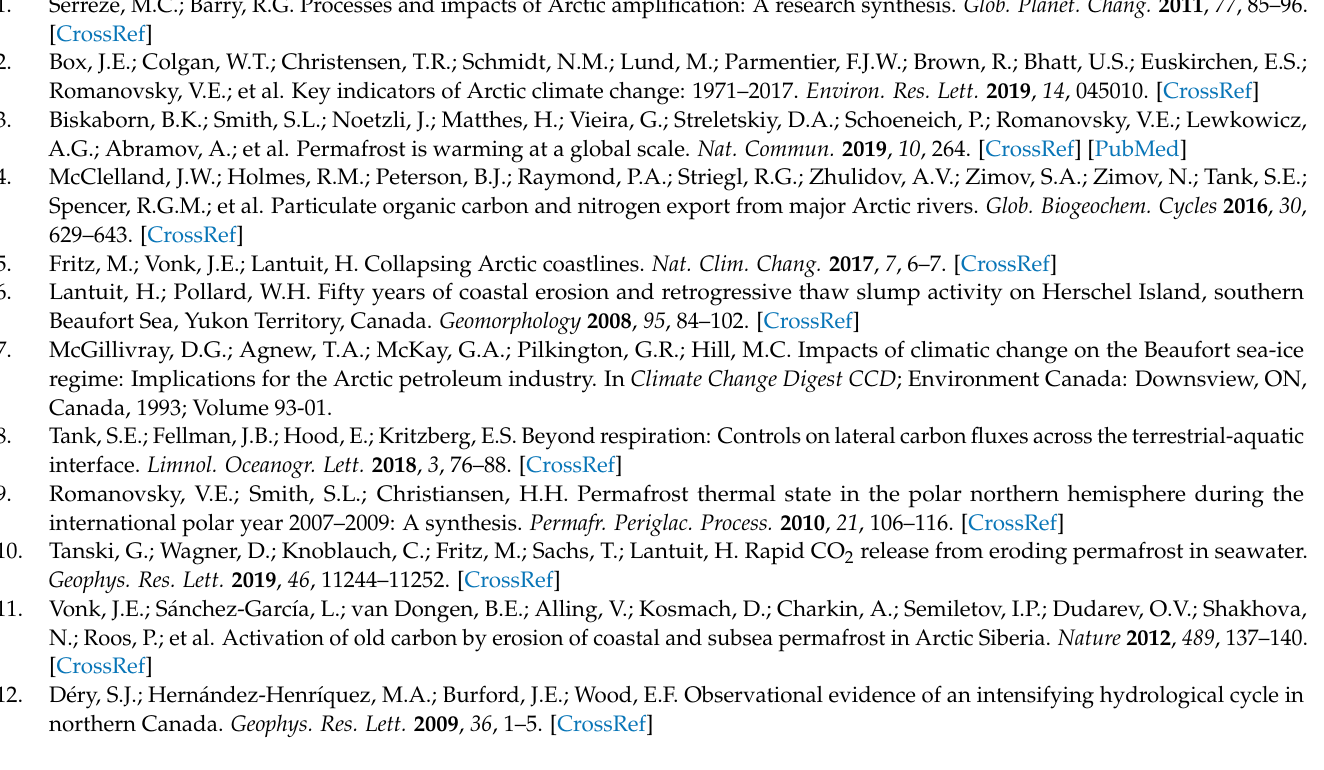
Figure A2. Wind plots on each day of satellite image recording during the 2019 summer season. Wind data were acquired from the ERA-5 reanalysis dataset 24 h prior to each image acquisition. Radial lines indicate the frequency of the wind direction over the sampling time: 25%, 50%, 75%, and 100%, respectively. During early and mid-Summer (Figure a – k ), easterly wind conditions are more common, while wind conditions remain unstable during Fall (Figure l – n ). Northwest is the main storm direction during the whole year.